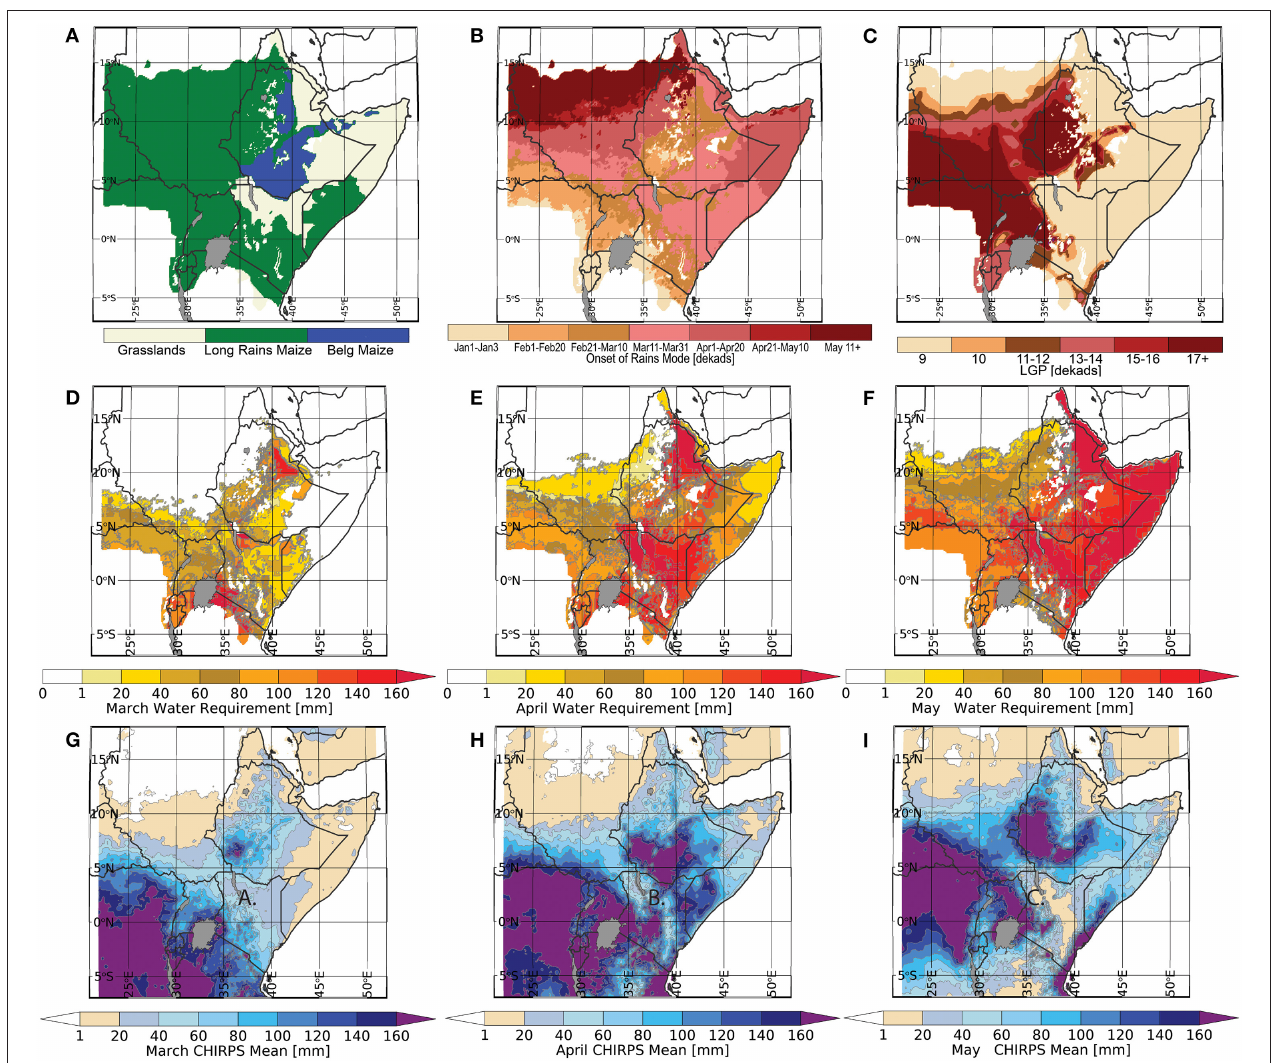
FIGURE 1 | (A) The three crop classes used to calculate Water Requirements. (B) The most frequent (modal) SOS dekad used to define the start of the season. (C) Mean LGP values, in dekads. (D–F) Average monthly crop WR totals in mm. (G–I) Average monthly CHIRPS precipitation totals in